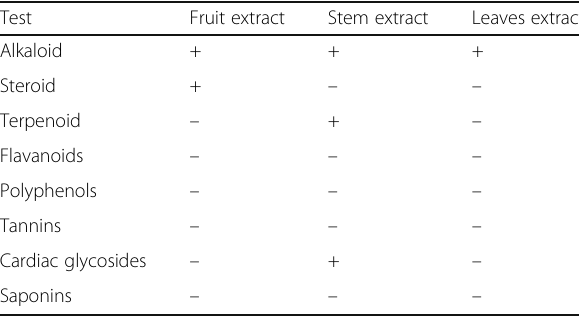
Table 1 Phytochemical Screening of chloroform extracts of Fruit, Stem, and Leaves of Helicteres isora L.